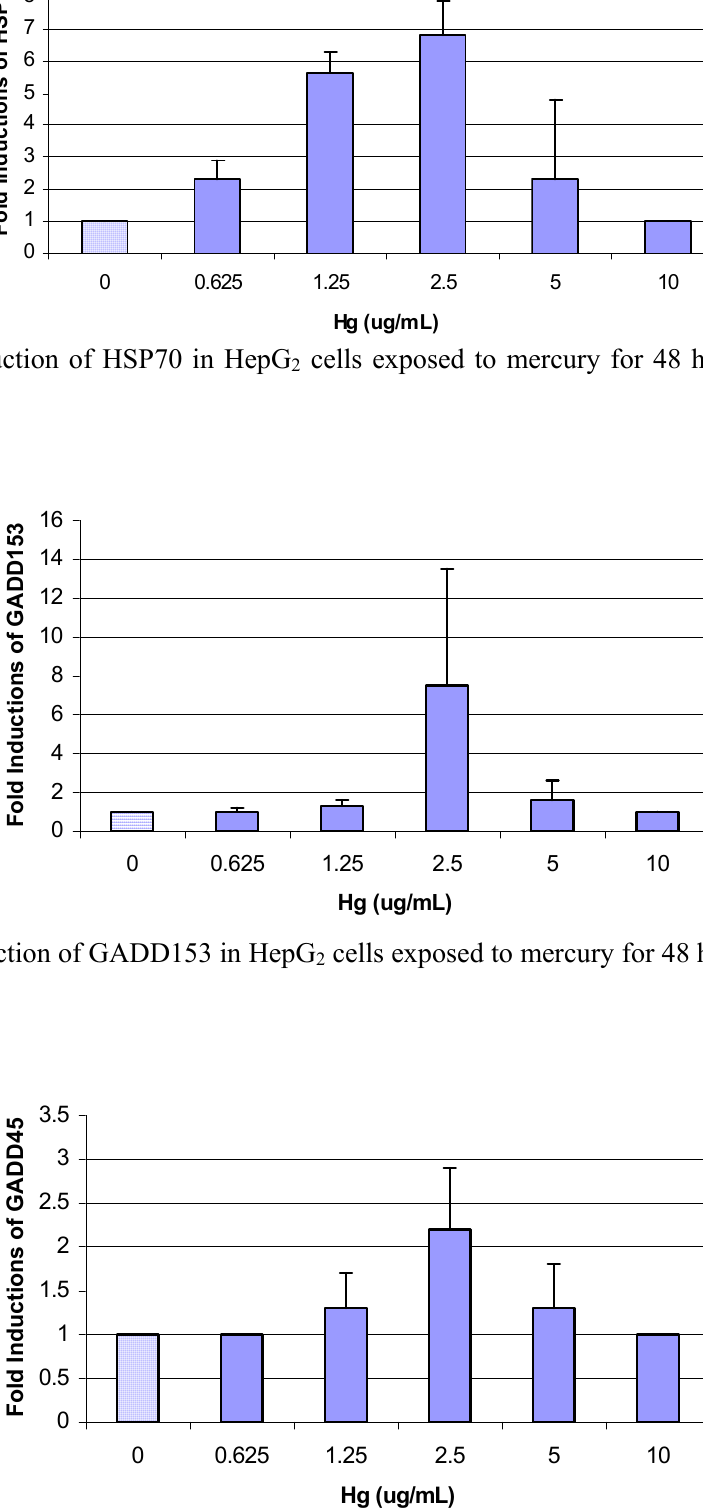
cells exposed to mercury for 48 hours. Data represent 2